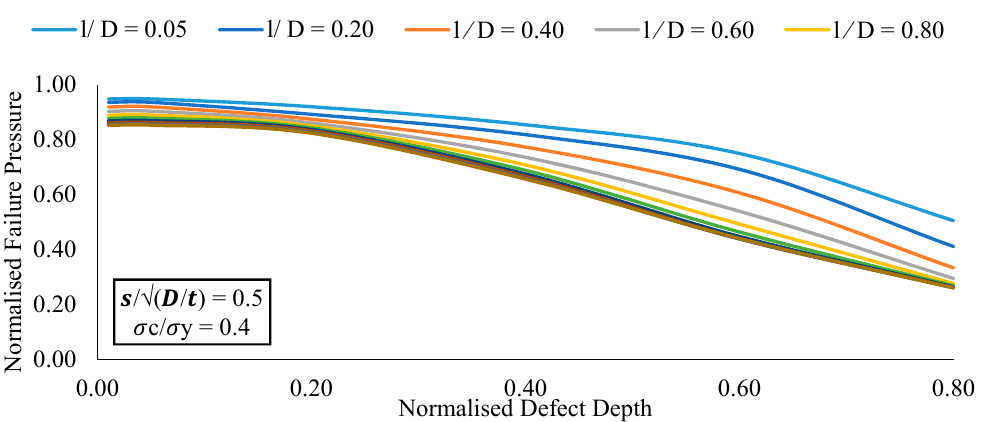
Figure 10. Normalized failure pressure against normalized defect depths for various normalized defect lengths at constant normalized defect spacing and normalized longitudinal compressive stress.